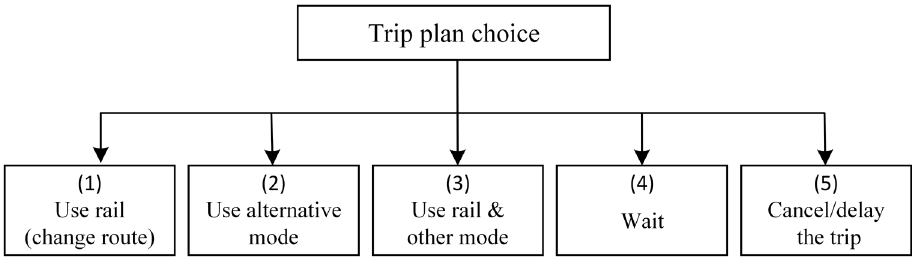
Figure 2. Possible trip plans for affected passengers.